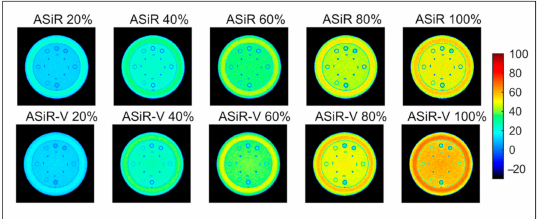
Figure 4. CTP404 phantom module. Maps of the percentage difference (%) between noise of the FBP-reconstructed CT image and noise of both ASiR-V-reconstructed and ASiR-reconstructed CT images with different blending levels (20%, 40%, 60%, 80%, and